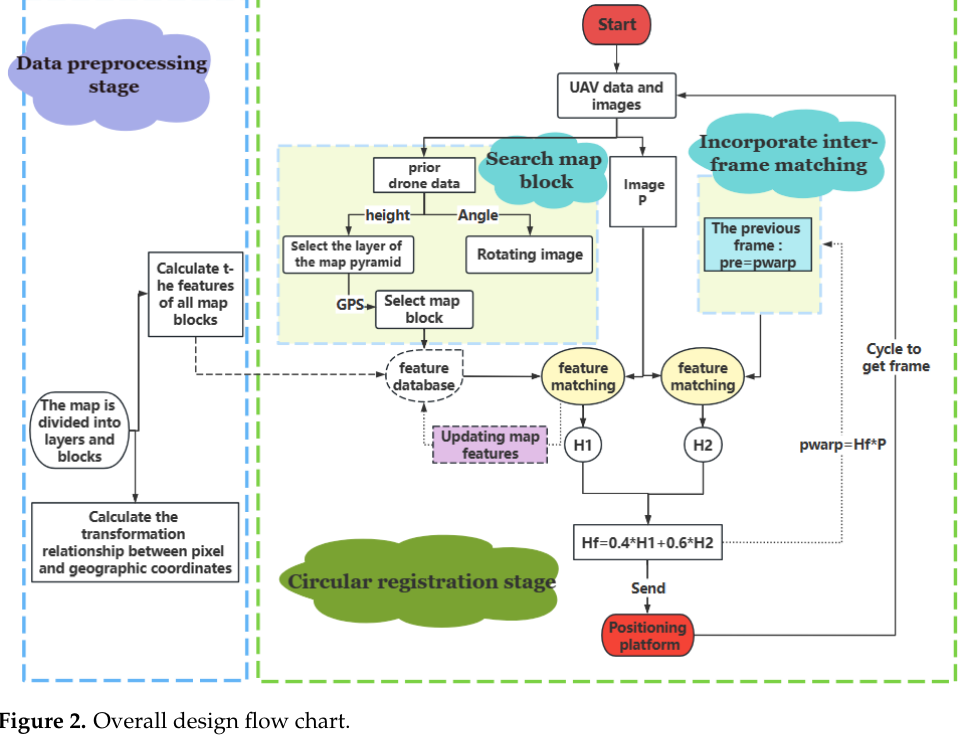
Figure 2. Overall design flow chart.